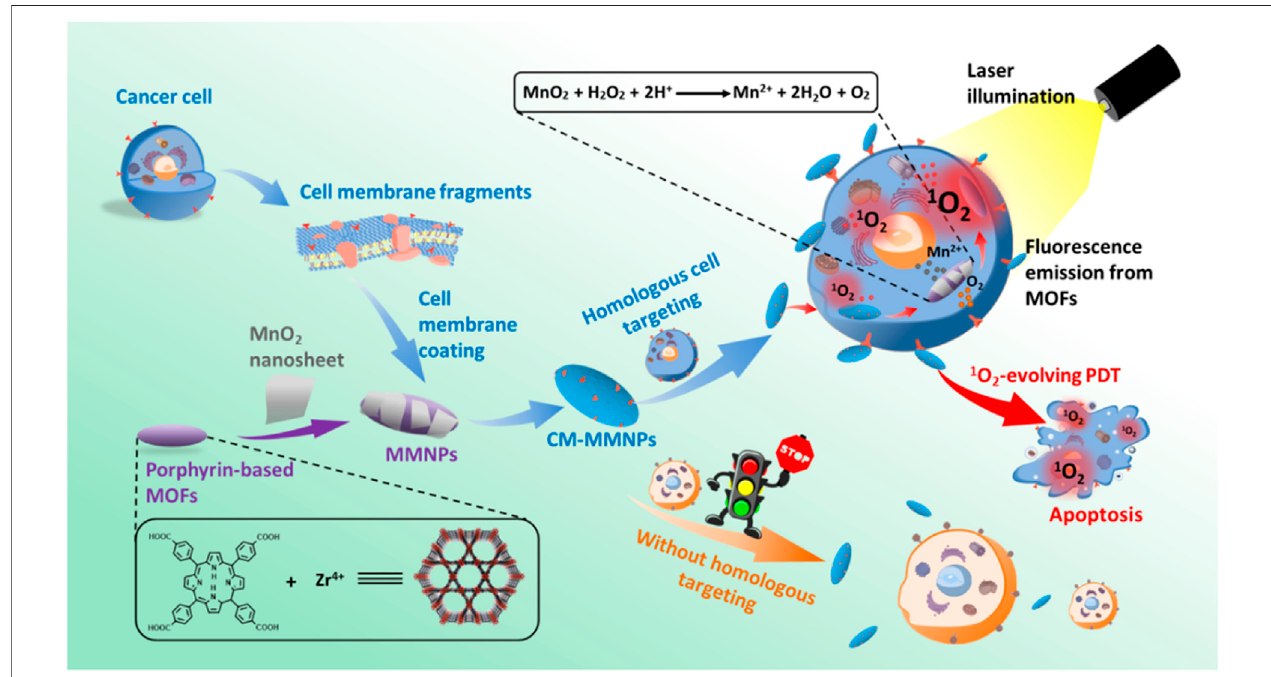
FIGURE 7 | Construction of a biomimetic system with homologous targeting, MRI/ fl uorescence dual-mode imaging, and PDT (Reproduced from Zhang et al., 2019).